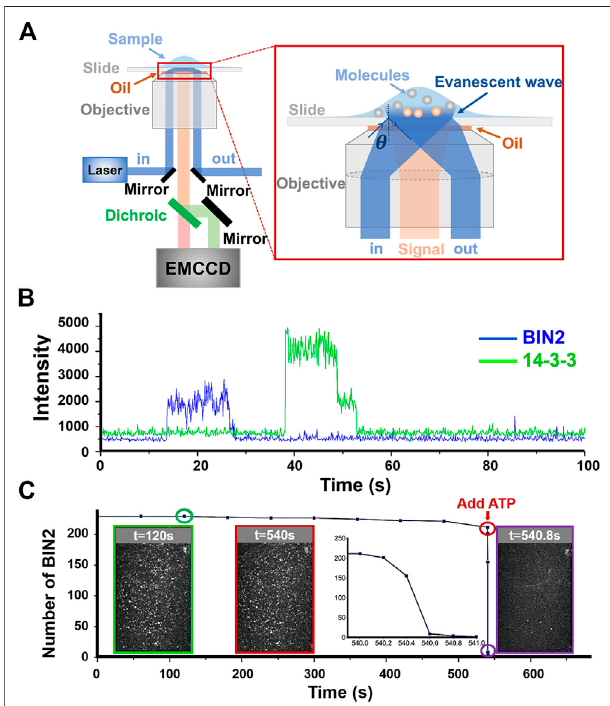
FIGURE 1 | Signal transduction of the Arabidopsis BR pathway monitoredwithTIRFmicroscopy. (A) Schematicofmulti-coloredmirror-based TIRFM [27]. In mirror-based TIRFM, the excitation laser (blue) will be re fl ected by the mirror and then refracted by the objective lens, fi nally incident on the sample surface at a total re fl ection angle. The fl uorescent signal (orange) will be collected by the objective and divided into two channels (green: donor; red: acceptor) by a dichroic before being detected by EMCCD. (B) Time- dependent fl uorescentintensitytracestrackingtheinteractionsbetweenBIN2 and 14-3-3. These two traces are collected by a multi-colored TIRFM design shown in A. The blue plateau represents the binding duration of BIN2, and green steps (with two photobleaching steps) means the arrival of 14-3-3 dimer. (C) Number changes of BIN2 after ATP arriving. Three intensity images show the distribution i.e. density of BIN2 binding stably on BES1at different times. The numbers of BIN2 have been counted and plotted in the inset. The TIRF images are the screen shots showing the number of bound BIN2 at time equals 120 (shown in green), 540 (red), and 540.8 (purple) sec, respectively. ATP was added at t = 540 s. Panel (C) is adapted from Ref.